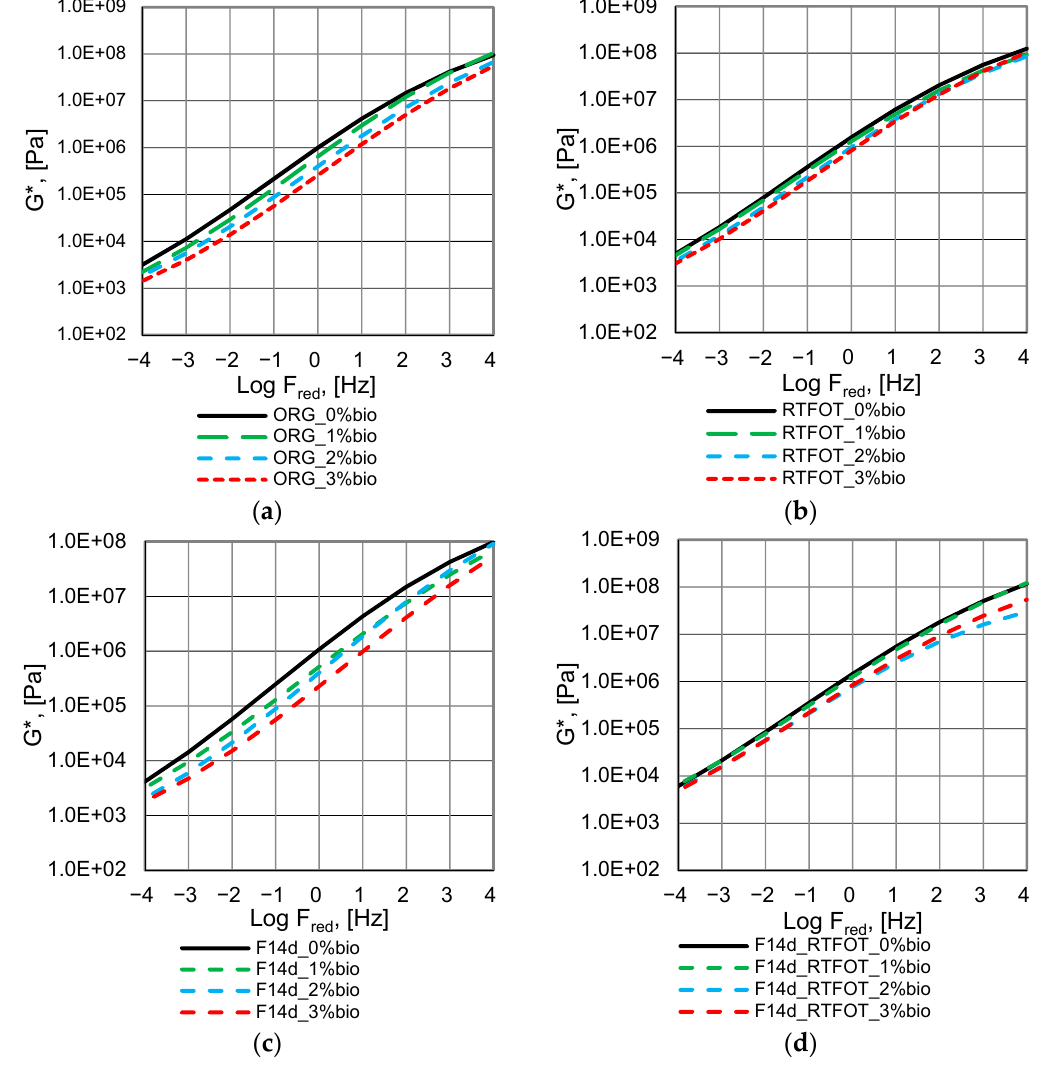
Figure 6. Master curves of complex modulus G* of the 45/80–80 highly modified bitumen: ( a ) non-foamed original bitumen; ( b ) non-foamed after RTFOT ageing bitumen; ( c ) foamed original bitumen; ( d ) foamed after RTFOT ageing bitumen.